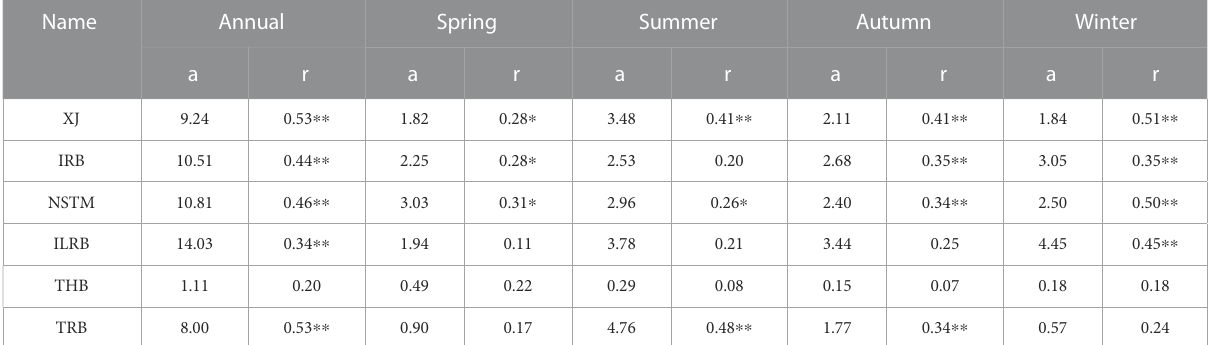
TABLE 2 Variation trends of annual and seasonal precipitation in XJ and its sub-regions (mm/10 a), and the results of signi fi cance tests.